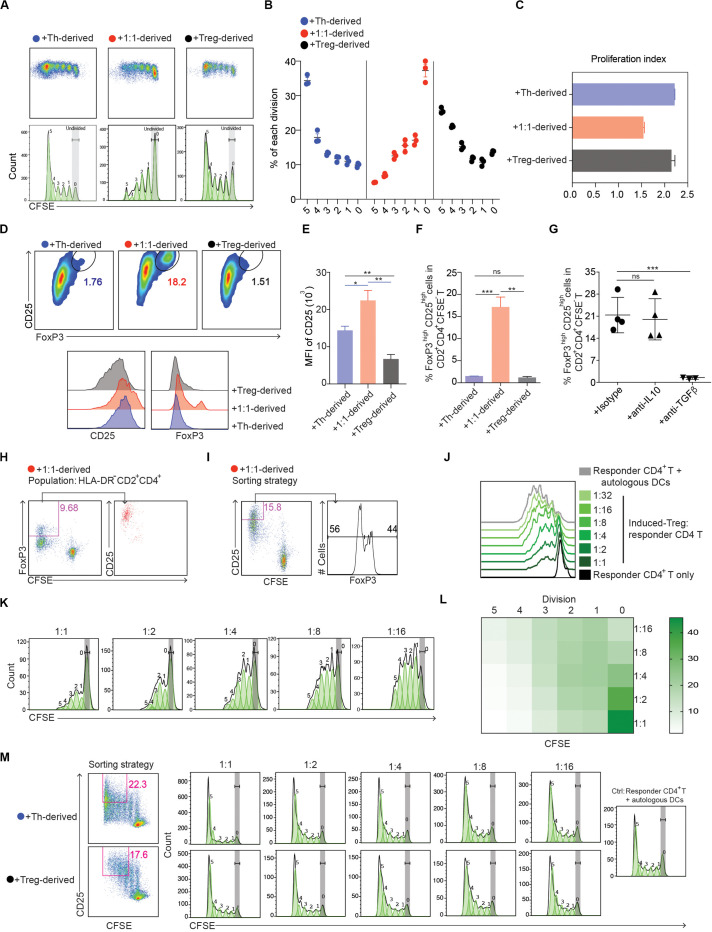
Human monocytes cultured with defined mixtures of Tregs and Th differentiate into cells that induce immune suppressive CD4+FoxP3+ Tregs. (A) Dotplots and histograms showing CFSE dilution of CD4+ T cells cultured with monocyte-derived cells from the CD4+ T cell-monocyte cultures. (B) Graphical representation of statistical analysis of CFSE– cell percentage (mean ± SEM, n = 3) obtained from (A). Similar results were obtained in two additional experiments. (C) Proliferation index calculated by Flowjo. (D) Expression of CD25 vs. FoxP3 in CFSE–CD2+CD4+ cells. Numbers adjacent to gated areas indicate percentage of gated cells. (E,F) Graphical representation of statistical analysis of the MFI of CD25 and the percentage of CD25highFoxP3high cells in CD2+CD4+CFSE– proliferated T cells. (G) CD14+ monocytes were cultured with Tregs and Th at a ratio of 10:1:1 in the presence of anti-IL-10, 2 μg/ml; anti-TGFβ, 2 μg/ml or isotype control antibody, 5 μg/ml. After 72 h, 1 μg/ml LPS was added, and 16 h later FACS-purified myeloid cells (DR+CD2–) were further cultured with MACS sorted CFSE-labeled naïve allogeneic CD4+ T cells. The percentage of FoxP3high cells in CD2+CD4+CFSE– cells was determined 6 days later. Mean ± SEM, n = 5. Similar results were obtained in two additional experiments. *P < 0.05; **P < 0.001; ***P < 0.0001; ns, not significant. Data were analyzed with one-way ANOVA, followed by Dunnett’s test for multiple comparisons. (H,I) 105 CFSE labeled CD45RA+CD4+ T cells were cultured with 5 × 104 allogeneic myeloid cells purified from 3-day cultures of monocytes, Tregs and Th at 10:1:1. After 6 days the cells were analyzed by flow cytometry. Responder CD4+ T cells were gated as CD2+CD4+. (H) CFSE–FoxP3+ DCReg-induced Tregs were analyzed for CD25 expression. (I) CD25 expression was used as the basis for sorting CD2+CD4+CFSE– cells. Percentages of FoxP3– and FoxP3+ cells in CD2+CD4+CFSE–CD25+ cells are shown. (J–M) CD2+CD4+CFSE–CD25+ cells induced by 1:1 (Th:Treg), Th or Treg-derived myeloid cells were purified by FACS and cultured in a new MLR containing 105 CFSE labeled allogeneic CD45RA+CD4+ cells and irradiated DCs (5 × 104) and anti-CD3 (0.5 ng/ml, plate-bound). After 84–90 h, proliferation of CFSE-labeled naïve responder CD4+ T cells was analyzed by flow cytometry. Cells were gated as DAPI–CD2+CD4+. Data are representative of 2 independent experiments. (J–L) Dose-dependent suppression of induced Tregs on responder CD4+ T cells. (L) Heatmap of statistical analysis of the responder CD4+ T cell proliferation as indicated by CFSE in each division defined by Flowjo. Mean ± SEM, n = 3. Similar results were obtained in both experiments.